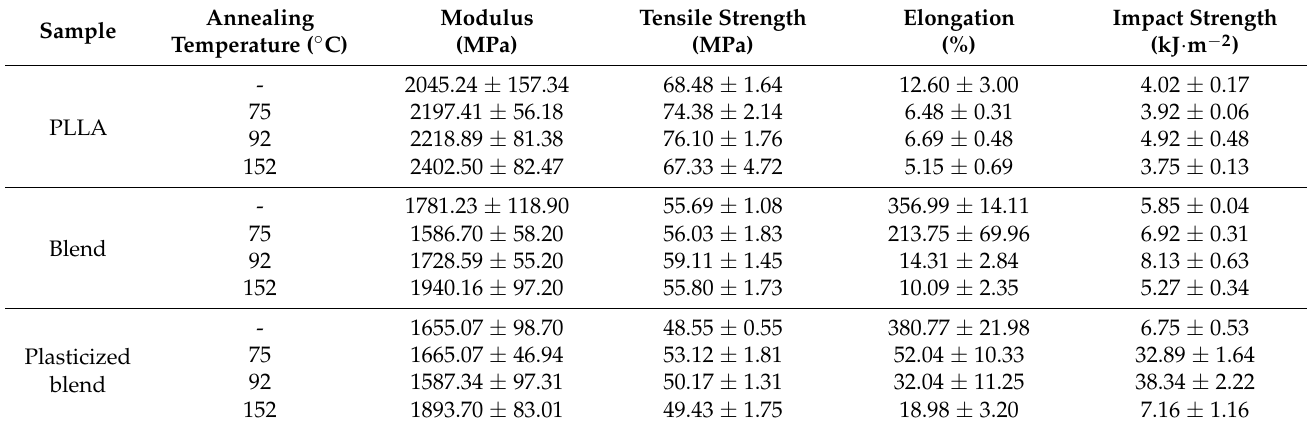
Figure 1. Stress–strain curves of PLLA, PBS, PLLA/PBS (80/20) blend, and plasticized blend containing 5% PEG. Table 1. Effect of annealing temperature on tensile modulus, strength, elongation at break, and impact strength of PLLA, PLLA/PBS blend, and plasticized blend. (Annealing time 10